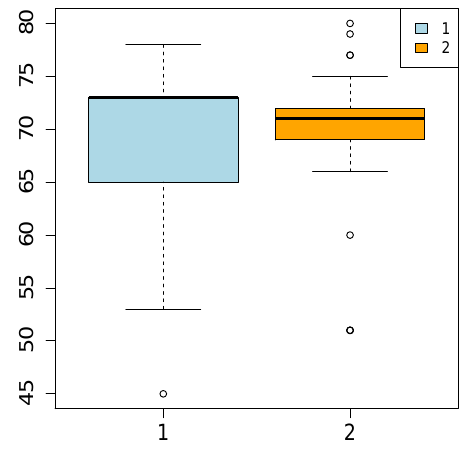
Figure 5. Boxplot of the variable “life expectancy” in clusters 1 and